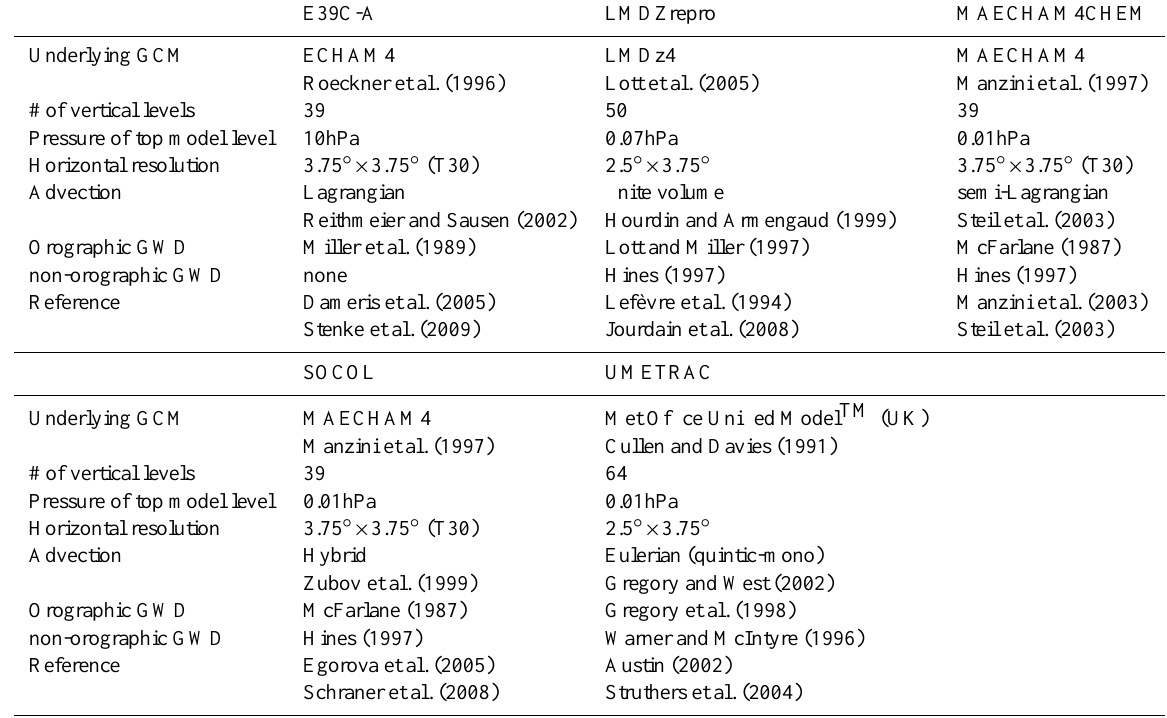
Table 1. Details of the CCMs